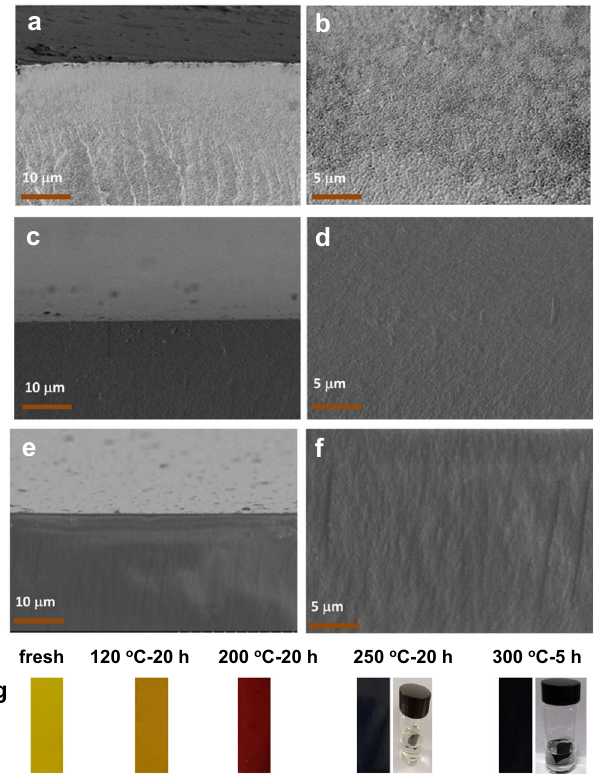
Fig. 2 SEM images and photos of polymer membranes after thermal crosslinking at varied temperatures. a , c , e Cross-sectional images of PIM- BM/TB, PIM-BM/TB-250 °C-10 h and PIM-BM/TB-300 °C-5 h. b , d , f Surface images of PIM-BM/TB, PIM-BM/TB-250 °C-10 h and PIM-BM/TB- 300 °C-5 h. g Photos of PIM-BM/TB treated at different